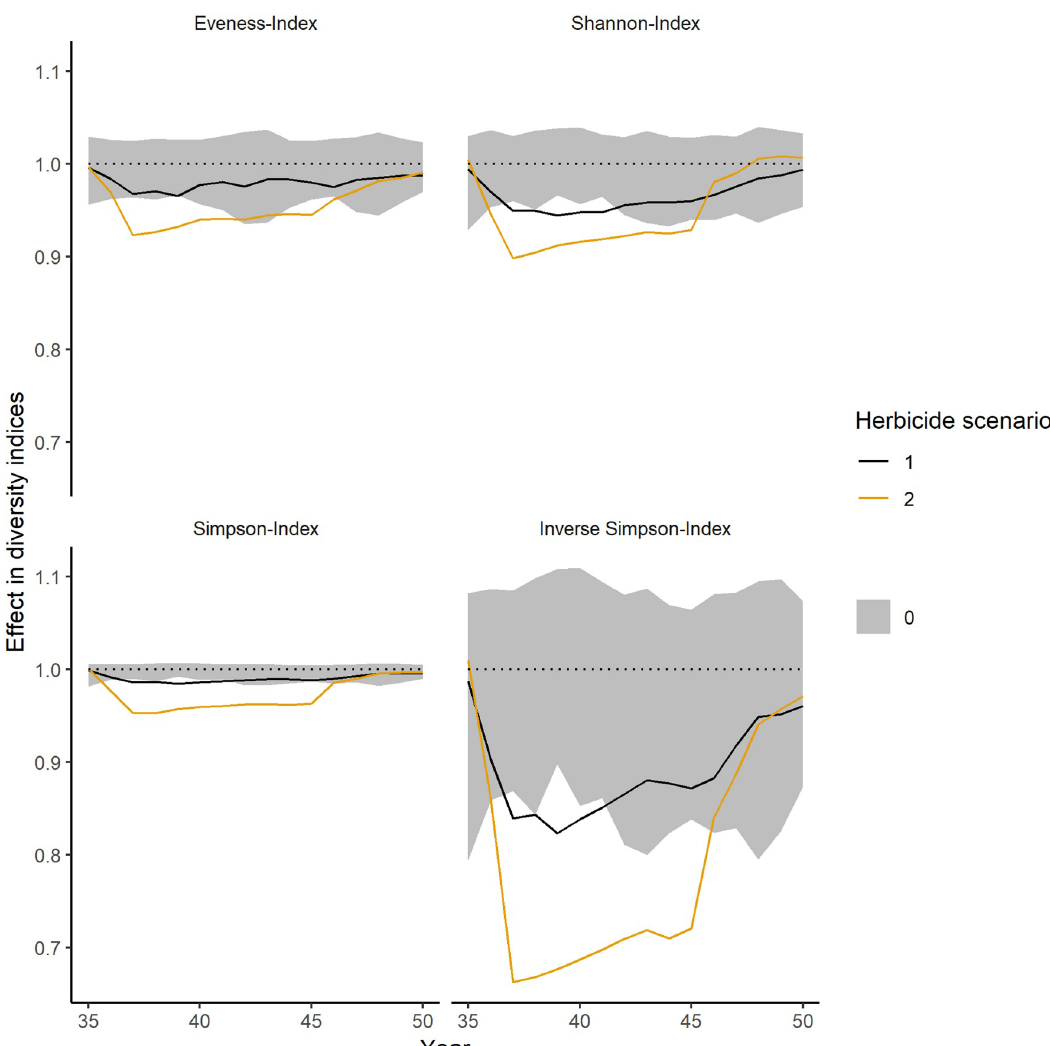
Fig 6. Long-term impacts on the diversity indices over the simulated herbicide application. Herbicide application started in year 36 (shown in Fig 5) and ended in year 45. Values below 1 represent a negative impact, values equal to 1 no impact and values above 1 a positive impact. The theoretical herbicide had an impact on biomass and mortality. PFTs had random dose response curves. Grey ribbons show the fluctuations within control simulations (averaged over each year), the black lines show the mean (averaged over each year) of the 1.1 g a.i./ha application rate (herbicide scenario 1), the orange line the mean (averaged over each year) of the 3.3 g a. i./ha application rate (herbicide scenario 2).